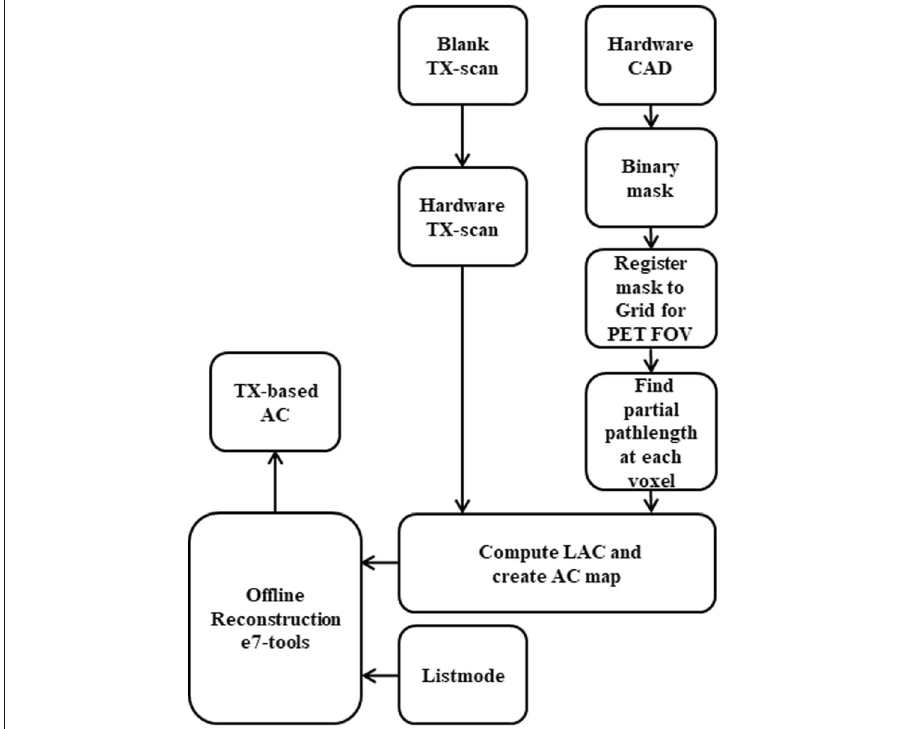
Fig. 2 Flow chart describing the process of generating hardware TX-based AC map using the PET/MRI scanner and a static radioactive